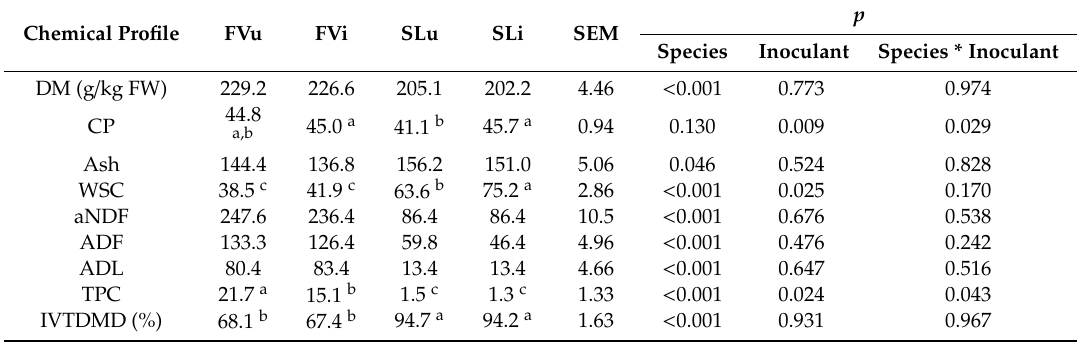
Table 1. Chemical composition and IVTDMD of the seaweed silages, treated with (FVi, SLi) and without (FVu, SLu) a Lactobacillus plantarum inoculant, after 90 days ( n = 3) (g/kg DM unless stated otherwise).